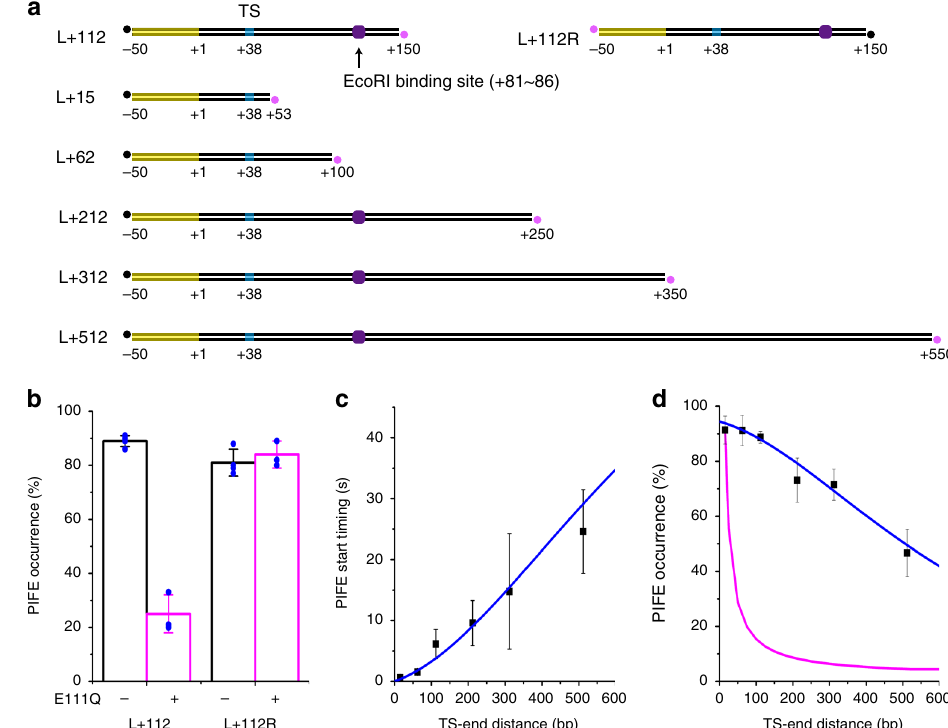
Fig. 4 Diffusion of RNAP on DNA after termination. a DNA templates with varying distance between TS (cyan oval) and Cy5-labeled end (magenta dot) with or without an EcoRI binding site (purple hexagon). b Reduction of Cy5 PIFE occurrence by a roadblock on L + 112 but not L + 112 R. c PIFE start timings plotted against TS-end distances. Cy5 PIFE start was timed since Cy3 vanishing from six templates, L + 15 through L + 512 (black squares). The timing data fi t to a 1D diffusion model (blue line). d PIFE occurrences plotted against TS-end distances. Cy5 PIFE was counted with six templates (black squares).